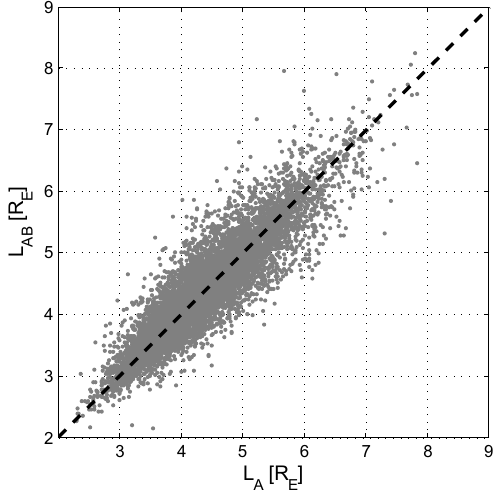
Figure 10. Comparison of Swarm A SSFAC indices with indices predicted from simultaneous Swarm B